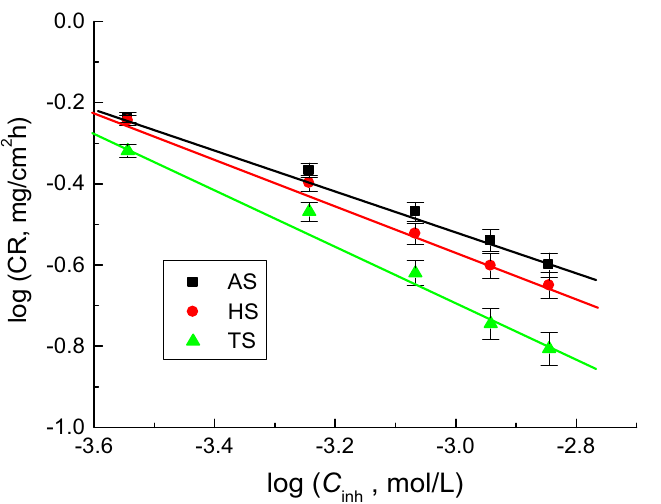
Figure 6. log CR vs. log C inh for the copper corrosion inhibition by the examined surfactants in 1.0 M H 2 SO 4 solution at 298 K.